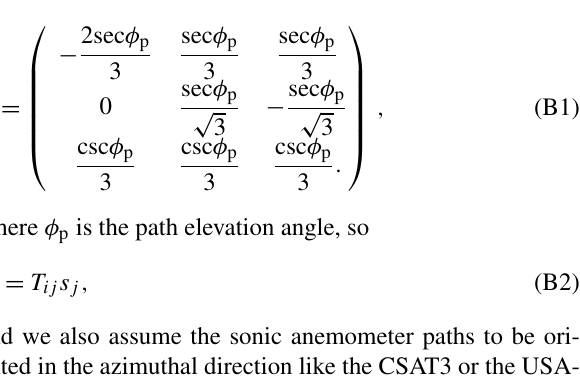
Since the u and v components behave identically in terms of noise, the error is also given by Eq. (B3) if the compo- nents are rotated into the mean wind direction coordinate system and as long as the wind vector is horizontal. Also, since the noise is assumed white, the relative strengths of noise-dominated spectra will also follow Eq. (B3). The ra- tio between the horizontal and vertical spectra will there- fore increase rapidly with path elevation angle as shown in Fig. B1. The unit ratio occurs for φ p = tan − 1 ( 2 − 1 / 2 ) ≈ 35 ◦ or at a path zenith angle of 90 ◦ − φ p ≈ 55 ◦ . This is also the path elevation angle where the sum of the three component variances obtains a minimum of exactly 3 times σ 2 . Because s of flow distortion, sonic anemometers do not have such a low path elevation